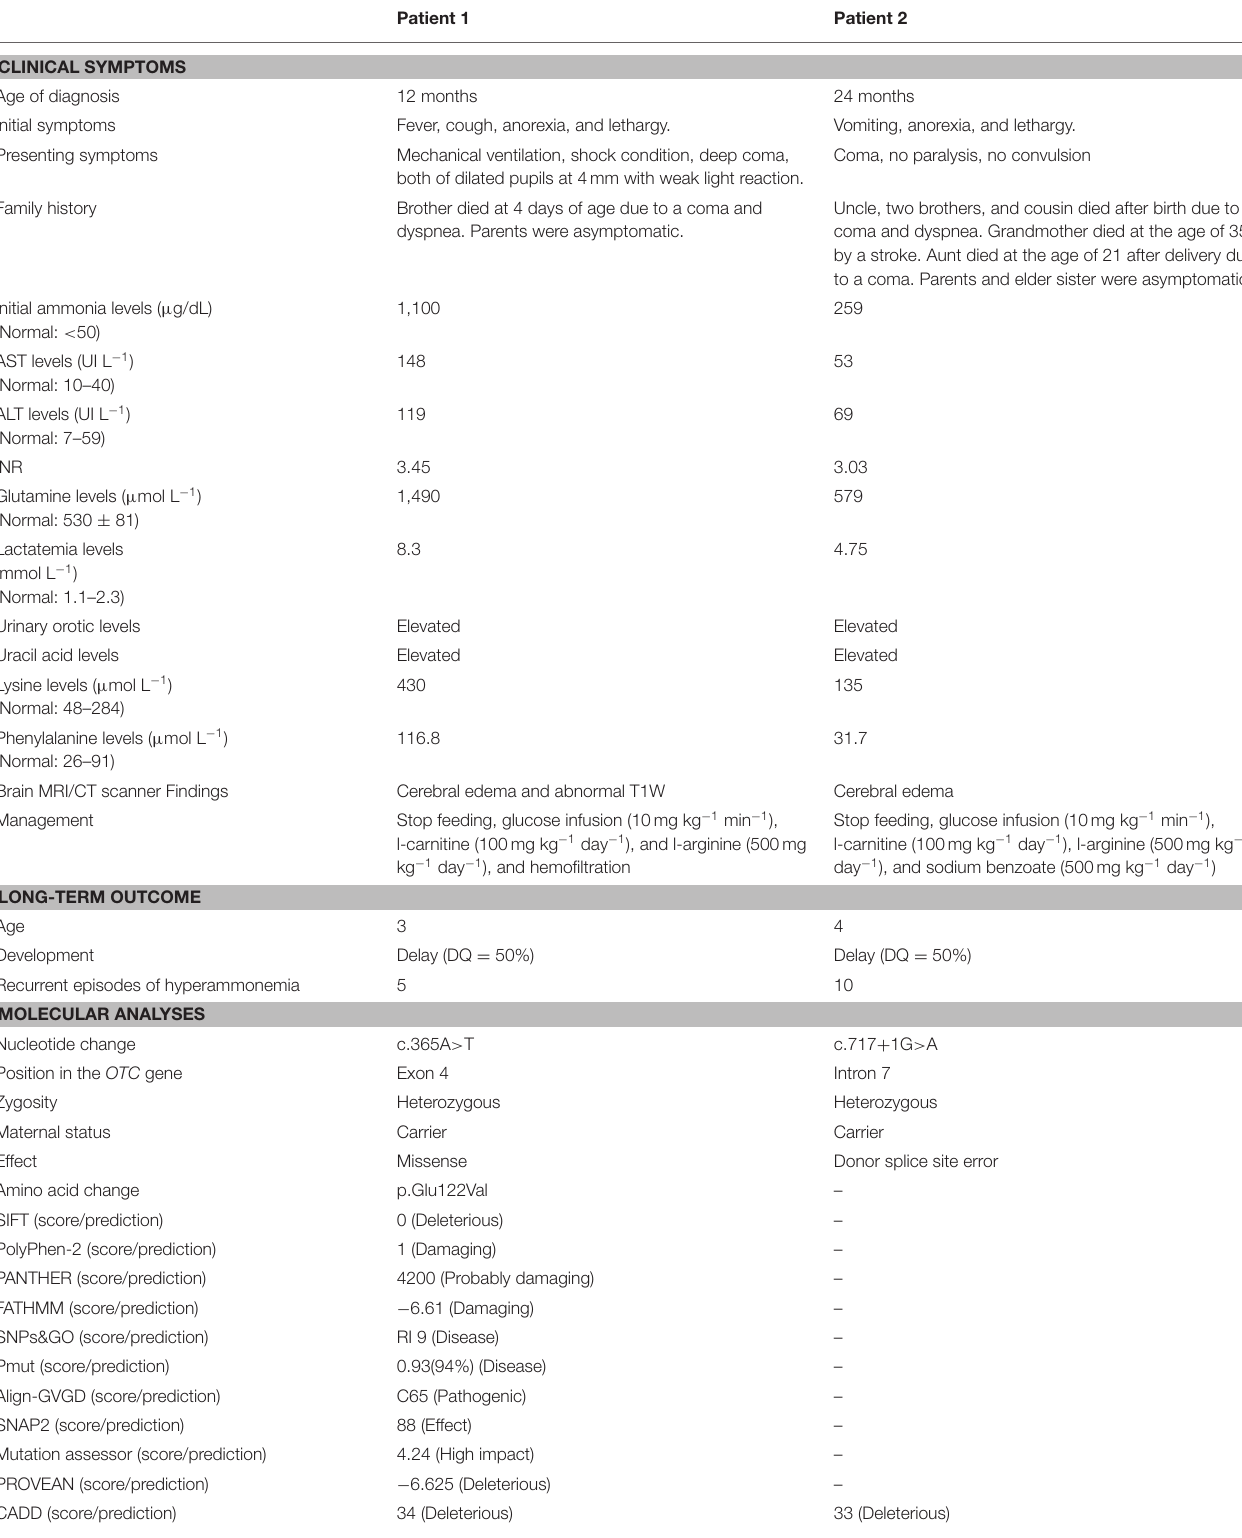
TABLE 1 | Clinical and molecular analyses of two Vietnamese female patients with